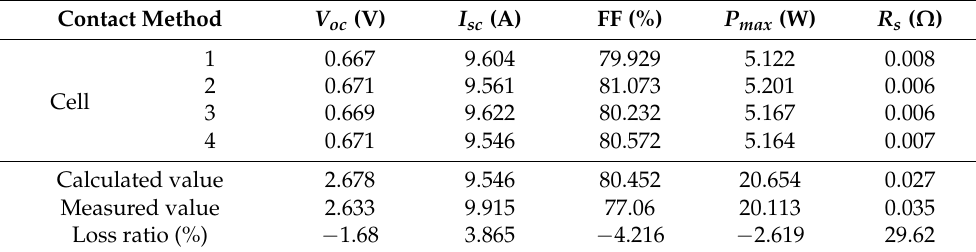
Table 3. Characteristics of a wire-embedded EVA sheet